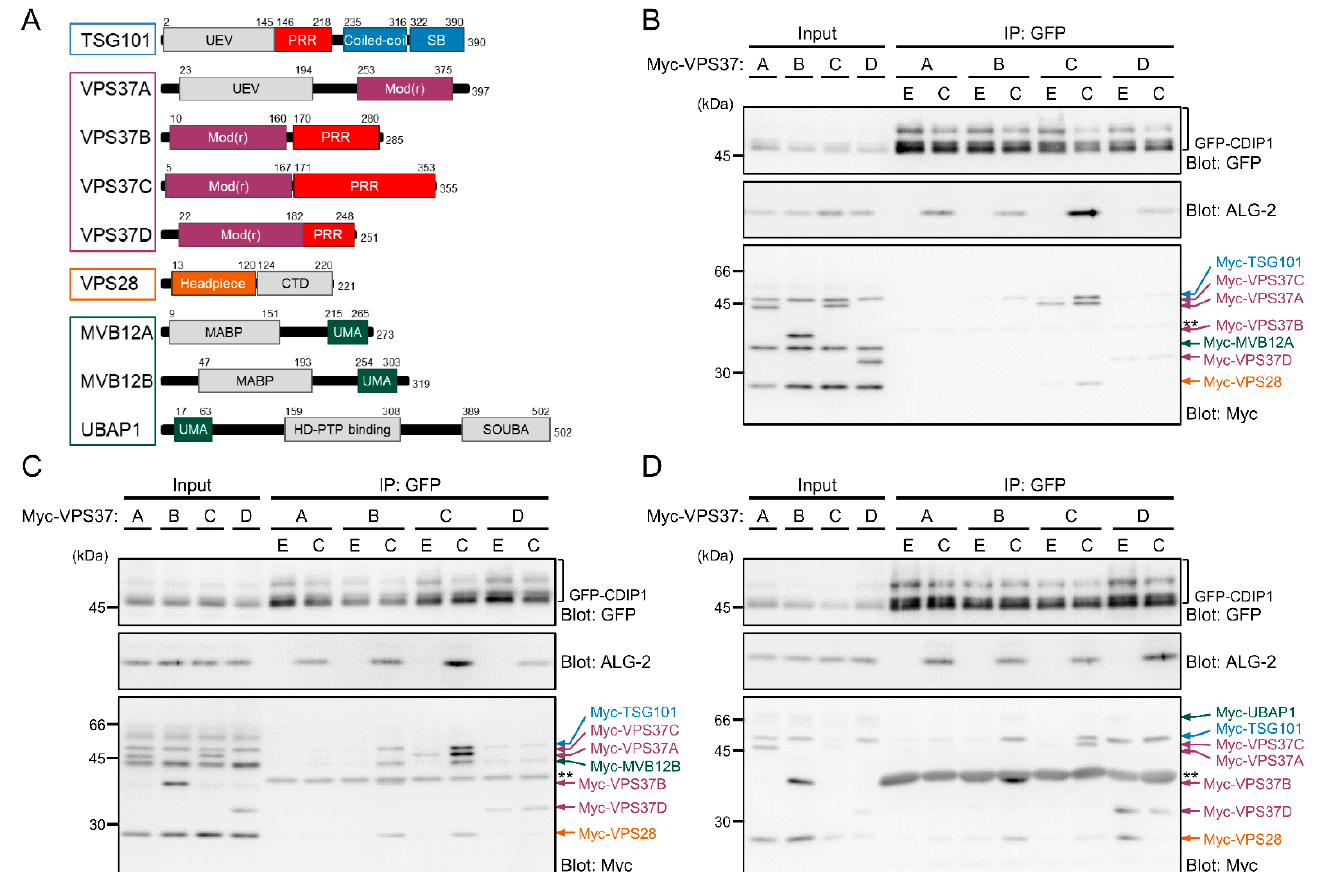
Figure 5. Different Ca 2+ dependence on interaction of CDIP1 with ESCRT-I isocomplexes. ( A ) Schematic diagrams of ESCRT-I subunits. UEV, ubiquitin E2 variant domain; PRR, Pro-rich region; SB, steadiness box; Mod(r), modifier of rudimentary domain; CTD, C-terminal domain; MABP, MVB12-associated β -prism domain; UMA, UBAP1-MVB12-associated domain; SOUBA, solenoid of overlapping UBAs domain. ALG-2 directly binds to PRRs of TSG101, VPS37B and VPC37C in the presence of Ca 2+ [12,45]. ( B – D ) ALG-2 KO HEK293 cells were transiently transfected with expression plasmids for GFP-CDIP1, ALG-2, Myc-TSG101, Myc-VPS28 and each isoform of VPS37A-D in combination with an expression plasmid for Myc-MVB12A ( B ), Myc-MVB12B ( C ) or Myc-UBAP1 ( D ). Cleared cell lysates (Input) and IP products (IP) obtained with the GFP nanobody in the presence of 5 mM EGTA (E) or 1 μ M CaCl 2 ( C ) were subjected to SDS-PAGE followed by immunoblotting with antibodies against GFP, ALG-2 and Myc tag. The relative amounts of cleared cell lysate proteins (Input) used for analysis of IP products (IP) were 10% (upper panel), 1.3% (middle panel) and 2% (lower panel). A double asterisk (**) indicates the migration position of GST-fused GFP nanobody in the IP products.